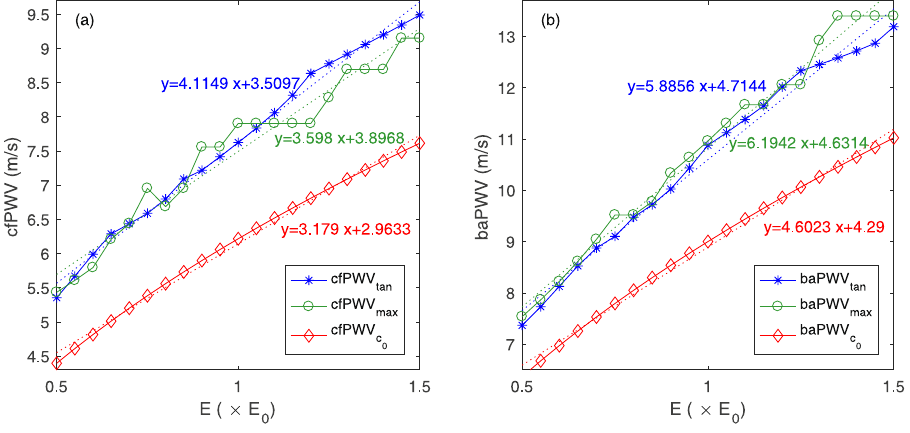
Figure 1. The effects of Young’s modulus on ( a ) cfPWVs and ( b )